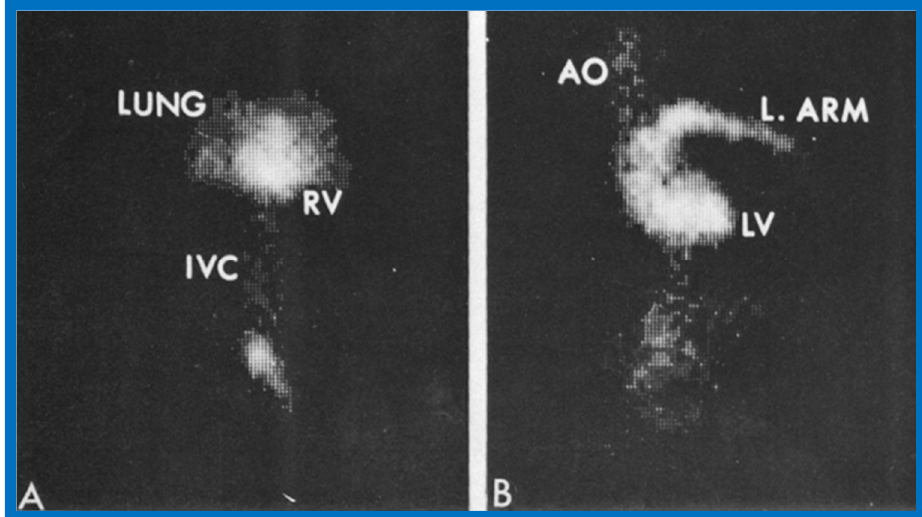
Figure 9. First pass radionuclide angiographic study of the patient with anomalous connection of the right superior vena cava to the left atrium. ( A ) When radionuclide material (tecnetium-99m macro-aggregated albumin) was injected into a vein in the foot, the inferior vena cava (IVC), right ventricle (RV) and lungs were seen, indicating normal drainage of the IVC into the right atrium. ( B ) When the injection was made into a vein of the left hand, the left (L) arm vein, the superior vena cava (not marked), left atrium (not marked), left ventricle (LV) and aorta (AO) were seen, indicating anomalous entry of the superior vena cava into the LA. Reproduced from Rao P.S.